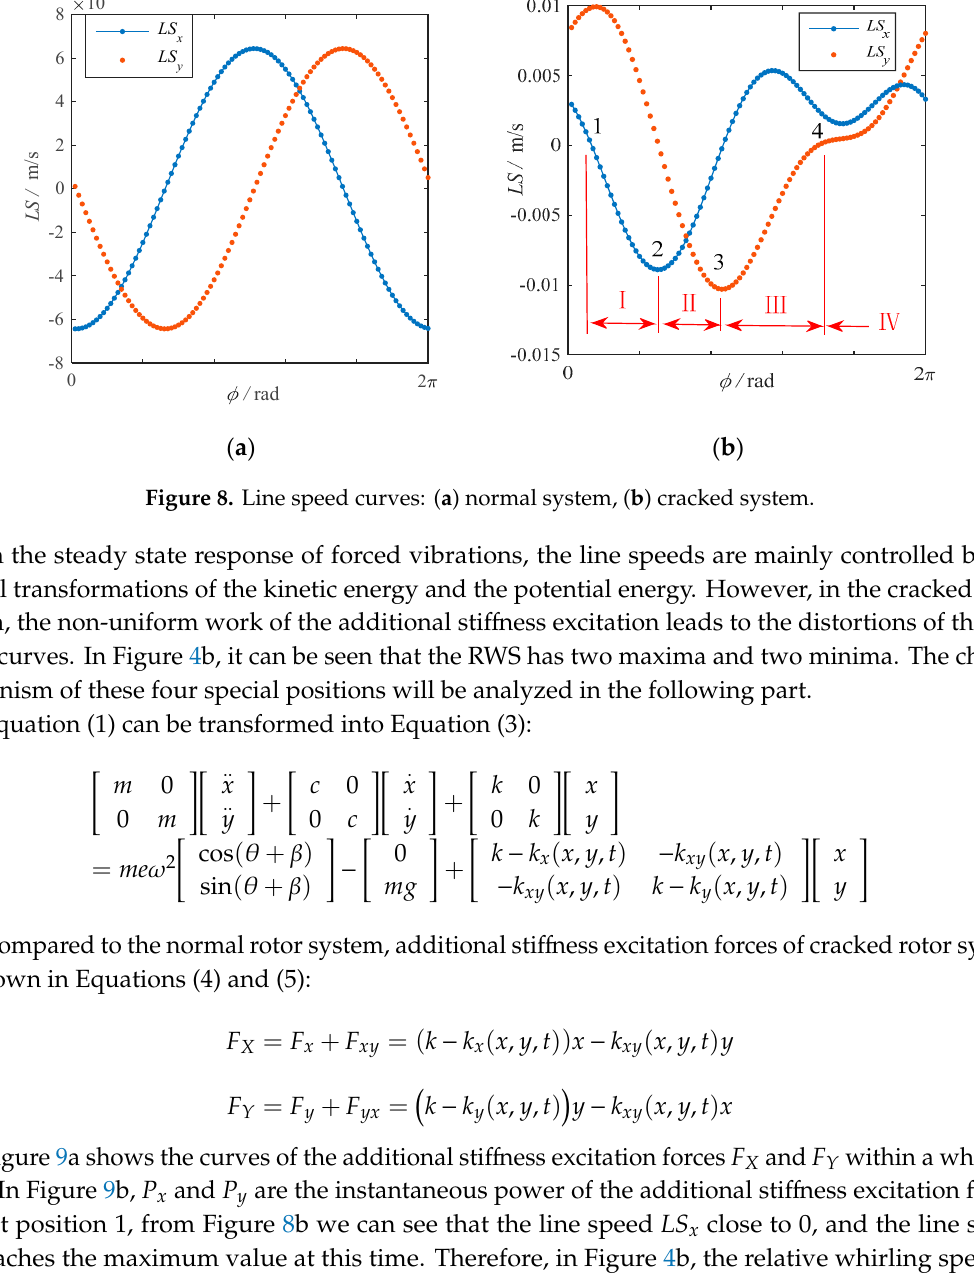
( b ) Figure 7. Comparison of RWS: ( a ) no crack, ( b ) with crack. 4. The Qualitative Mechanism Explanation To further understand the cause of this transient characteristic, this section studies the relationship between the breathing effect of the crack and the transient variation characteristics of the RWS with regard to the work of the additional stiffness excitation. First, the line speed is introduced as the intermediate state variable. The whirling speed can be decomposed into the linear speed LS x and LS y along the X-direction and Y-direction respectively. The line speeds of the normal rotor system and the cracked rotor system are shown in Figure 8. In Figure 8a, it can be seen that the line speeds LS x and LS y of the normal rotor are standard sine curves, and